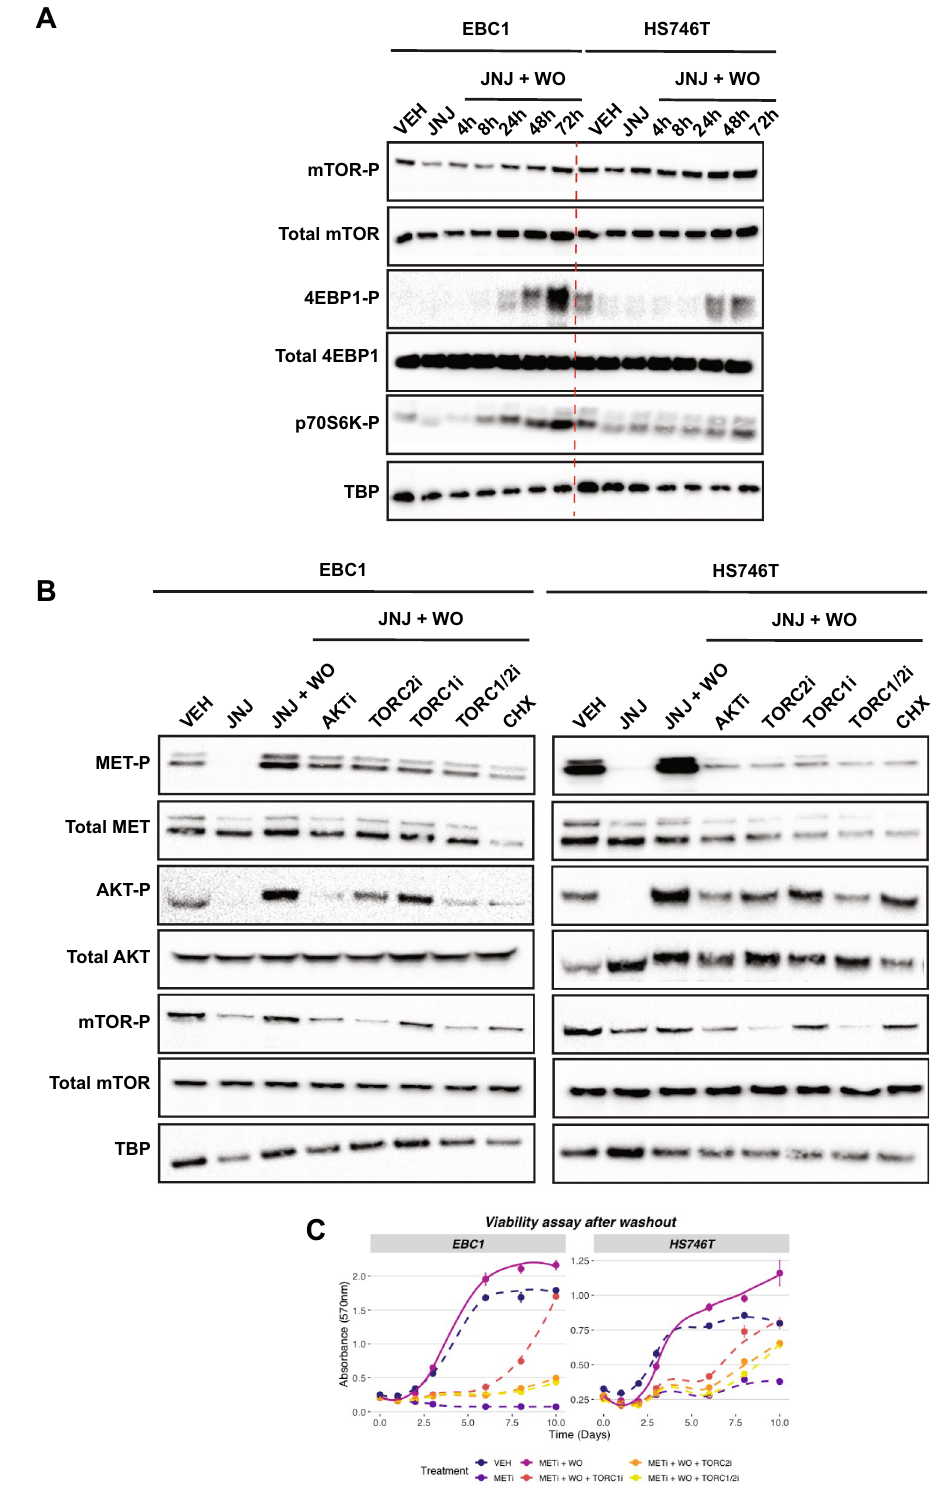
Figure 2. mTOR pathway is activated during the ‘flare’ effect. ( A ) EBC1 and HS746T cell lines were treated ON with JNJ-605 or DMSO (VEH). Following inhibitor withdrawal (WO), cells were harvested at the indicated time points (h). Total cellular lysates from the samples shown on top were immunoblotted, as indicated on the left. Black-edged rectangles delineate the blot. The dashed red vertical line highlights the separation between cell lines for clarity. ( B ) Cells were treated ON with JNJ- 605 or DMSO (VEH). After JNJ-605 WO, 1uM of MK-2206 (AKTi), 1uM of JA-AB2-011 (mTORC2i), 0.1uM of rapamycin (mTORC1i), 1uM of Temsirolimus (mTORC1/2i), or 25uM of cycloheximide (CHX) were added in the culture medium. Cells were lysed for immunoblotting 48 h later. Black-edged rectangles delineate the blot. ( C ) Viability assay of EBC1 and HS746T cells subjected to indicated treatments. Results are mean +/− SEM with N =